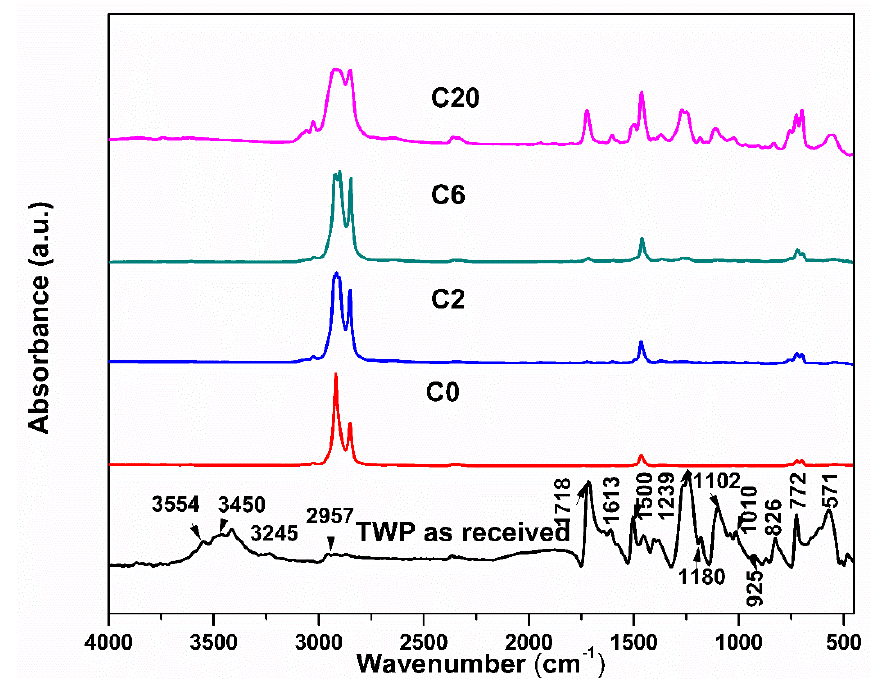
Figure 3. Fourier transform infrared (FTIR) spectrum of the TWP and composite samples.